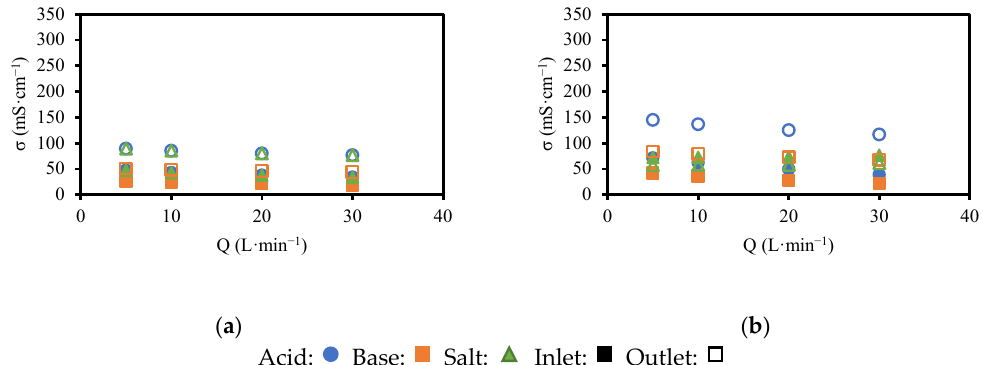
Figure A2. Values of conductivity versus feed flowrate: ( a ) T ‐ 200 ‐ I ‐ ERS; ( b ) T ‐ 400 ‐ I ‐ ERS.